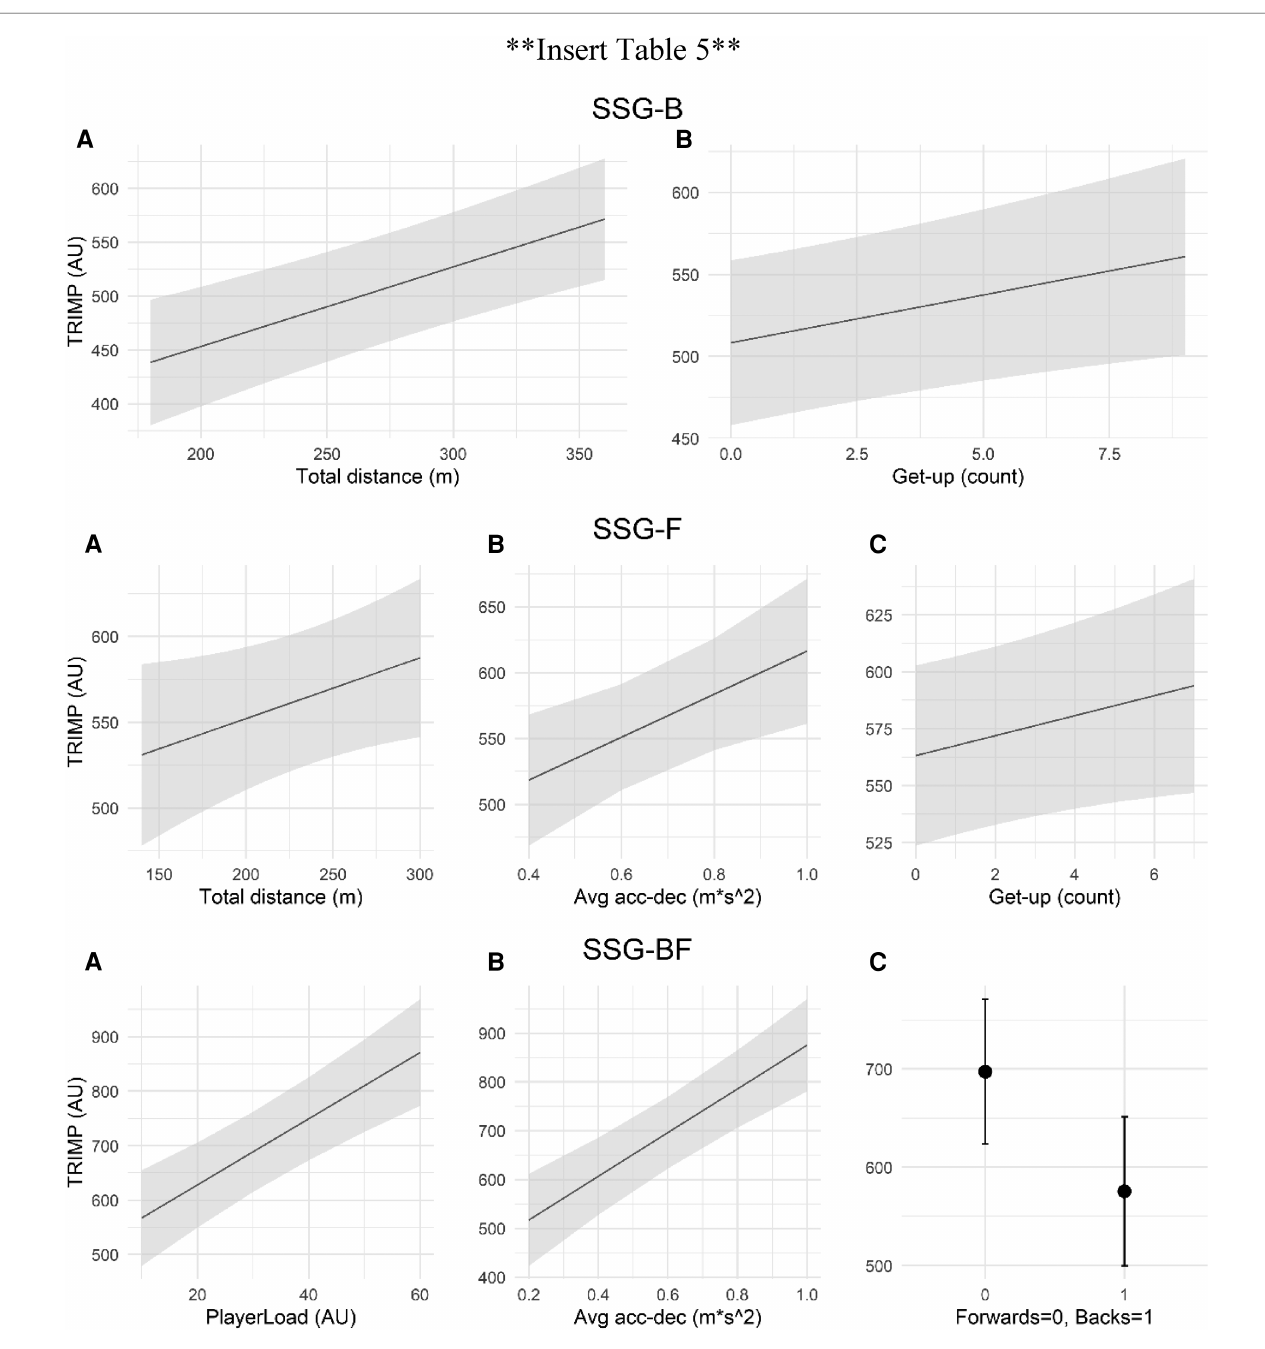
FIGURE 2 Representation of the model estimates for each fi xed-effect ( A-C ) in the three small-sided game designs (i.e., SSG-B, SSG-F,